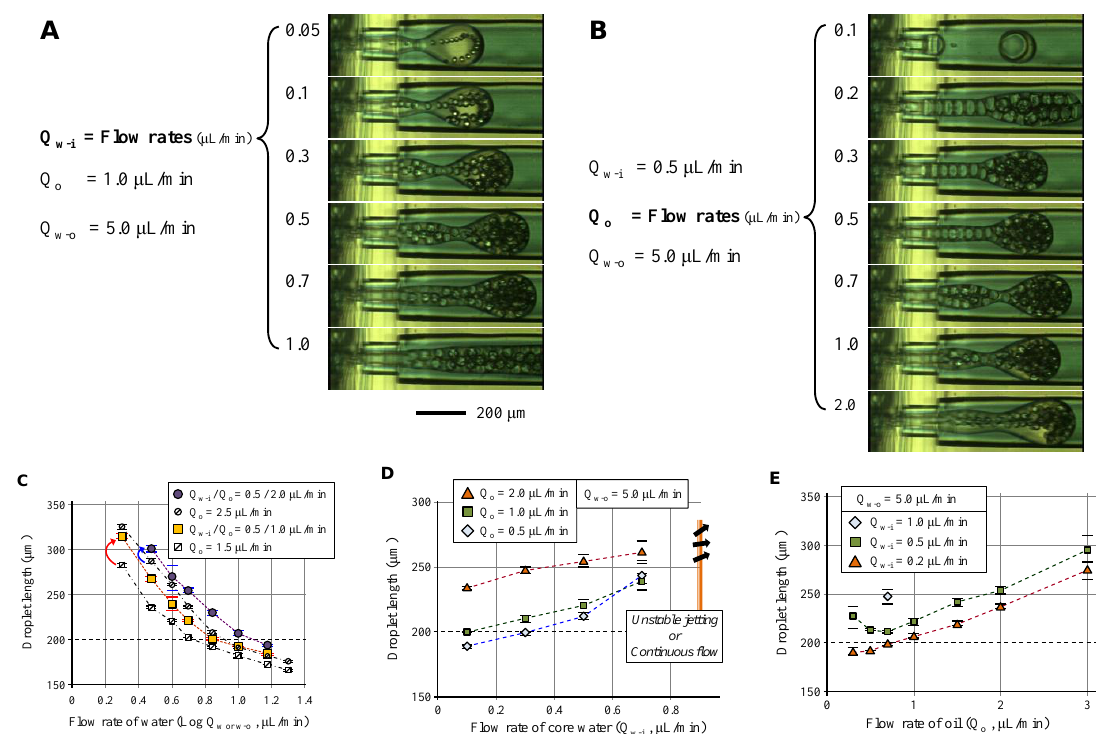
Figure 8. Control of the droplet size via flow rates of core phase flow ( A , D ), shell phase flow ( B , E ), and continuous phase flow ( C ).